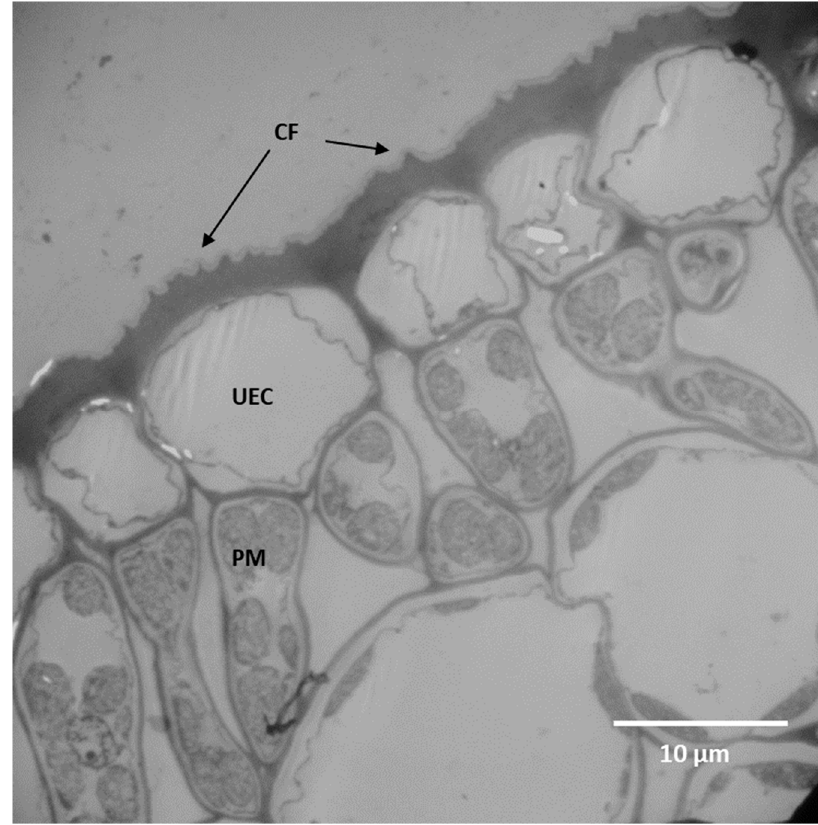
Figure 6. The anatomical modification of the epidermis in the adaxial side of the leaf in Rothmannia capensis . CF: cuticle fold, PM: palisade mesophyll cell, UEC: upper epidermal cell wall, and LE: lower epidermal cell.